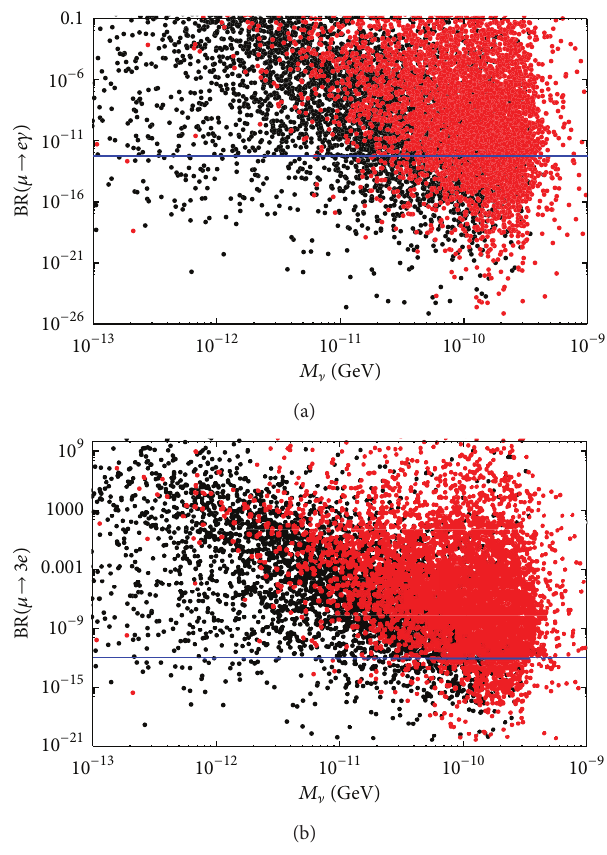
Figure 2: (a) BR( 𝜇 → 𝑒𝛾 ) and (b) BR( 𝜇 → 3 𝑒 ) as a function of the light neutrino masses in GeV (black: ] 1 , red: ] 2 ). The blue horizontal lines represent the actual experimental limits, from [18] and [19], respectively. The parameters have been chosen as 𝑚 0 ∈ [ 0 . 4 , 2 ] TeV, ∈ [ 1 . 0 , 2 . 0 ] TeV, tan 𝛽 ∈ [ 5 , 40 ] , 𝐴 ∈ [− 4 . 0 , 4 . 0 ] TeV, tan 𝛽 󸀠 ∈ 𝑀 1 / 2 0 ∈ [ 2 . 5 , 3 . 5 ] TeV, 𝑌 ∈ 1 ⋅ [ 0 . 002 , 0 . 4 ] , and 𝑌 ∈ [ 1 . 05 , 1 . 15 ] , 𝑀 𝑍 󸀠 𝑥 ] 1 ⋅ [ 0 . 05 , 5 ] × 10 − 6 .